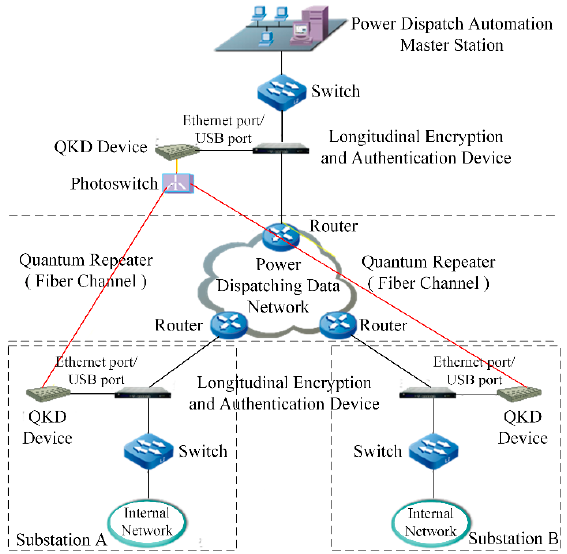
Figure 6. Dispatching automation system based on QKD.